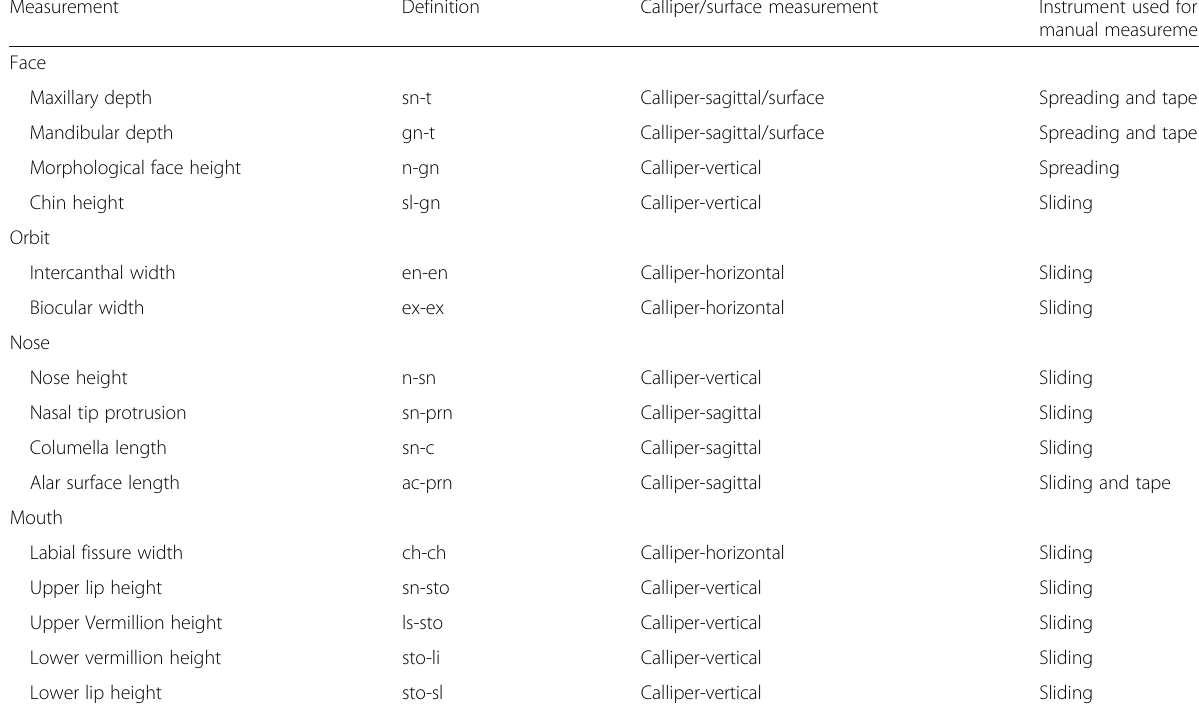
Table 1 Facial surface landmarks and method of measurement undertaken Measurement Definition Calliper/surface measurement Instrument used for